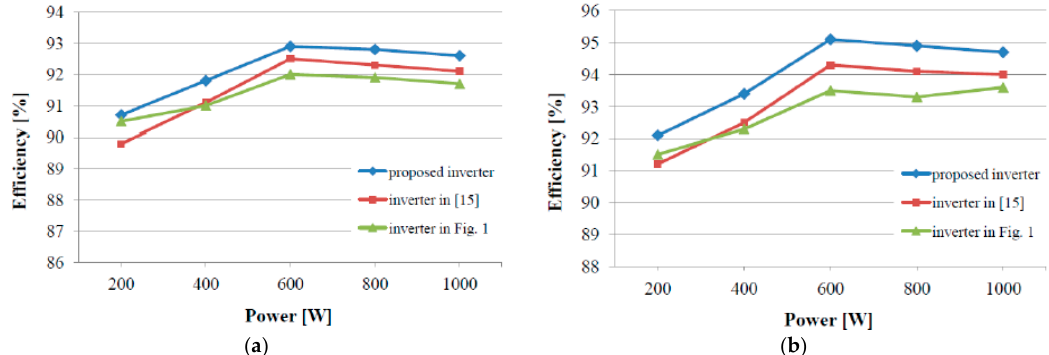
Figure 10. Power efficiency curves: ( a ) when IGBTs were adopted; ( b ) when SiC MOSFETs were